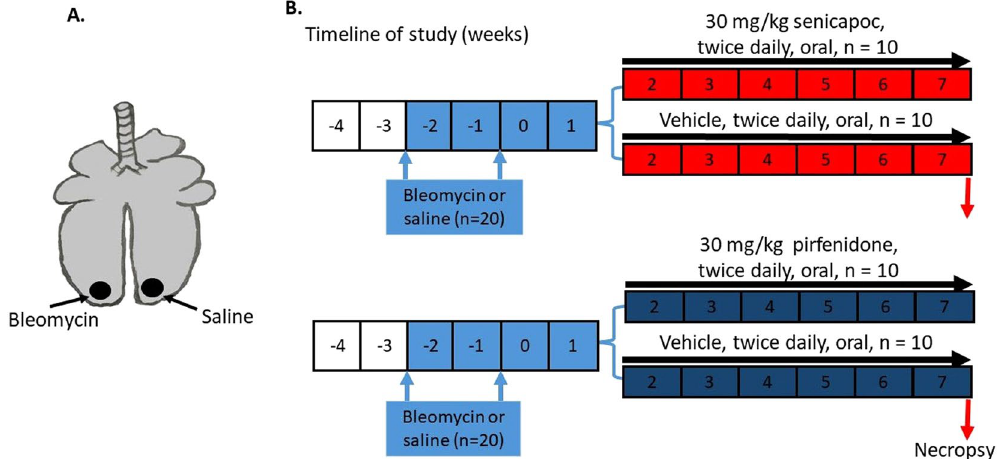
Figure 7. Induction of pulmonary fibrosis and therapeutic intervention in sheep. ( A ) Schematic diagram depicting the bleomycin and saline treatments administered to individual caudal lung segments in sheep. One lung segment received bleomycin, while the contralateral segment in the same sheep received saline as internal control. ( B ) Diagram showing the timeline for treatment of tested drugs (senicapoc or pirfenidone) or vehicle (methylcellulose), and euthanasia of experimental